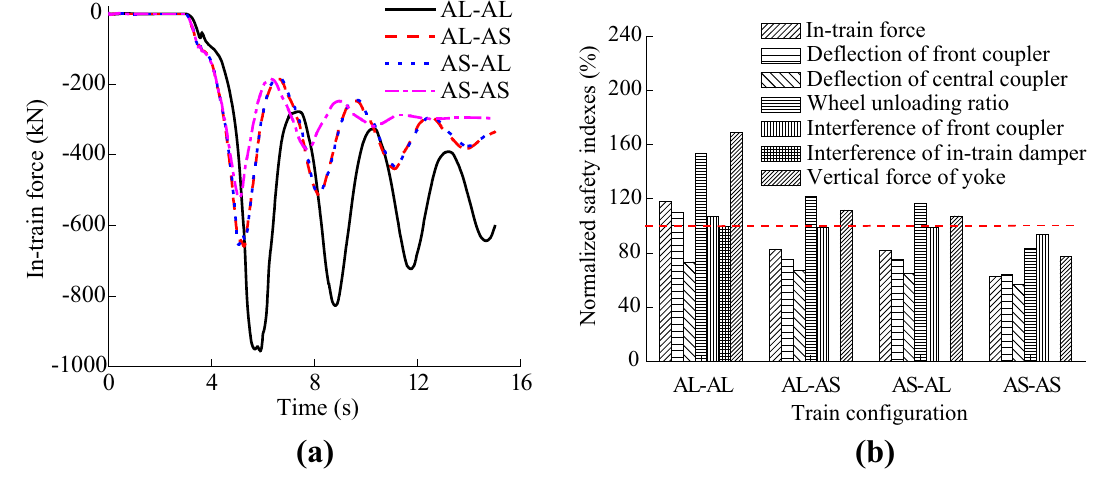
Fig. 10 Calculated results of rescue. a In-train force. b Normalized safety